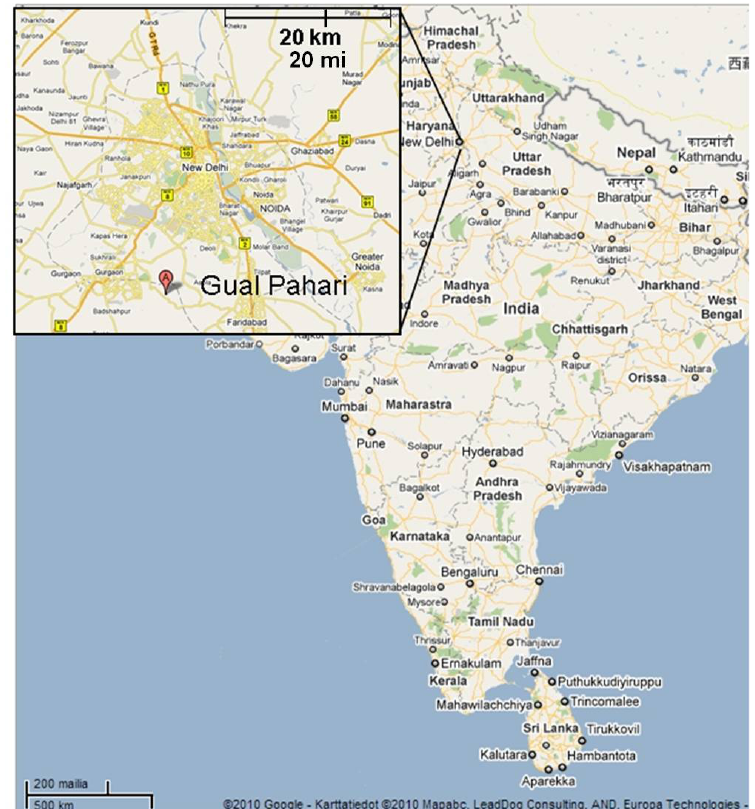
Fig. 1. Location of the Gual Pahari measurement